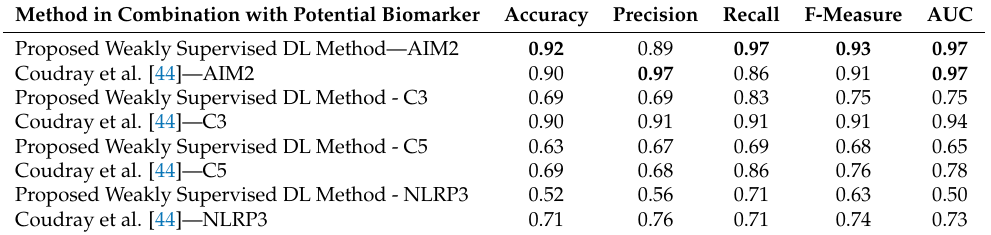
Table 3. First experiment:Quantitative evaluation in classification of therapeutic outcomes.